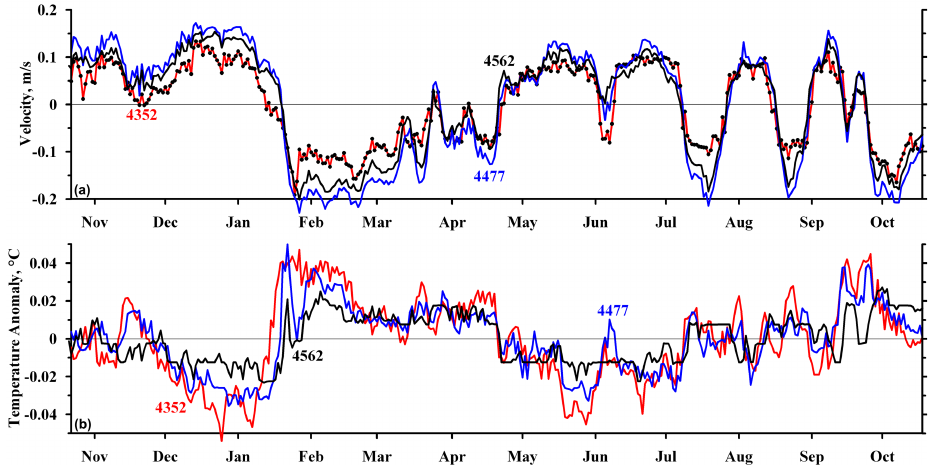
Fig. 11. Graphs of the current component along the main axis of the Kane Gap (north to south direction, positive to the north) (a) and temperature anomaly (b) . The bottom axis shows the sequential months of measurements.